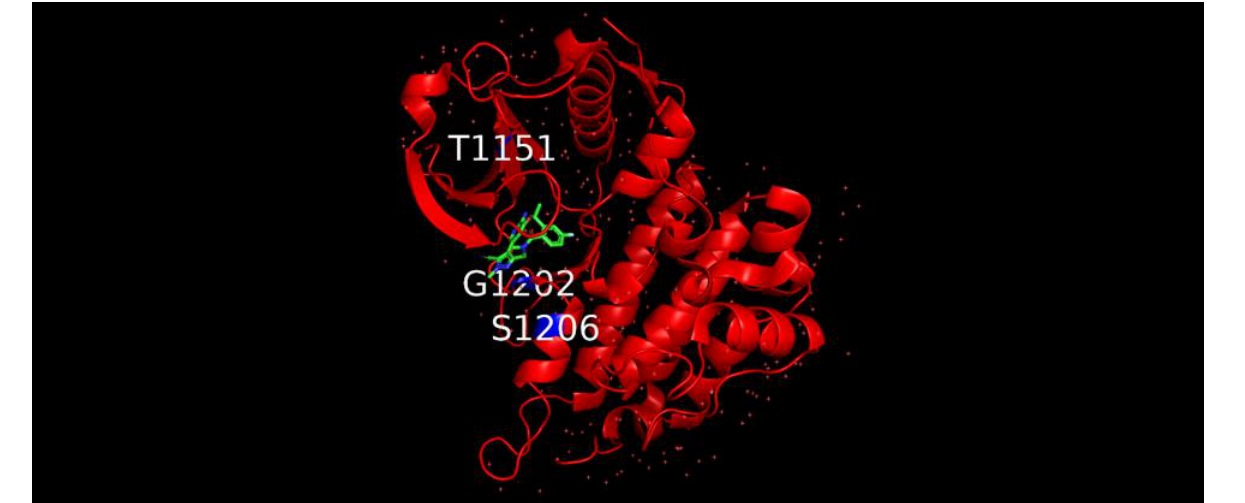
Figure 2. ( a , b ) Results of the prediction of the Chou and Fasman algorithm for ( a ) alpha-helix and ( b ) beta-sheet. A decrease was observed in the propensity score at the position of the three alterations.